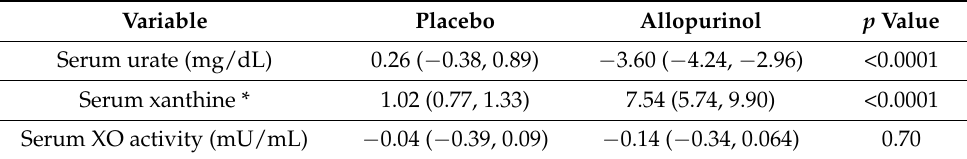
Table 3. Allopurinol, compared to placebo, did not affect serum XO activity.